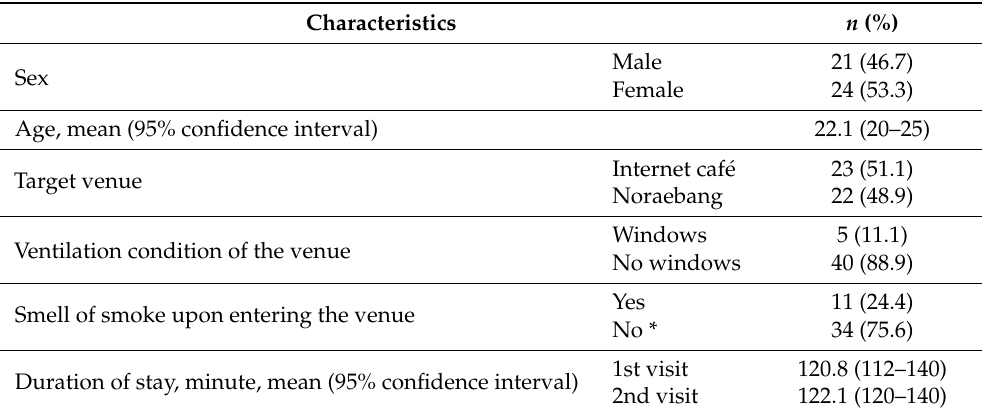
Table 1. Characteristics of participants and target venues and duration of stay.